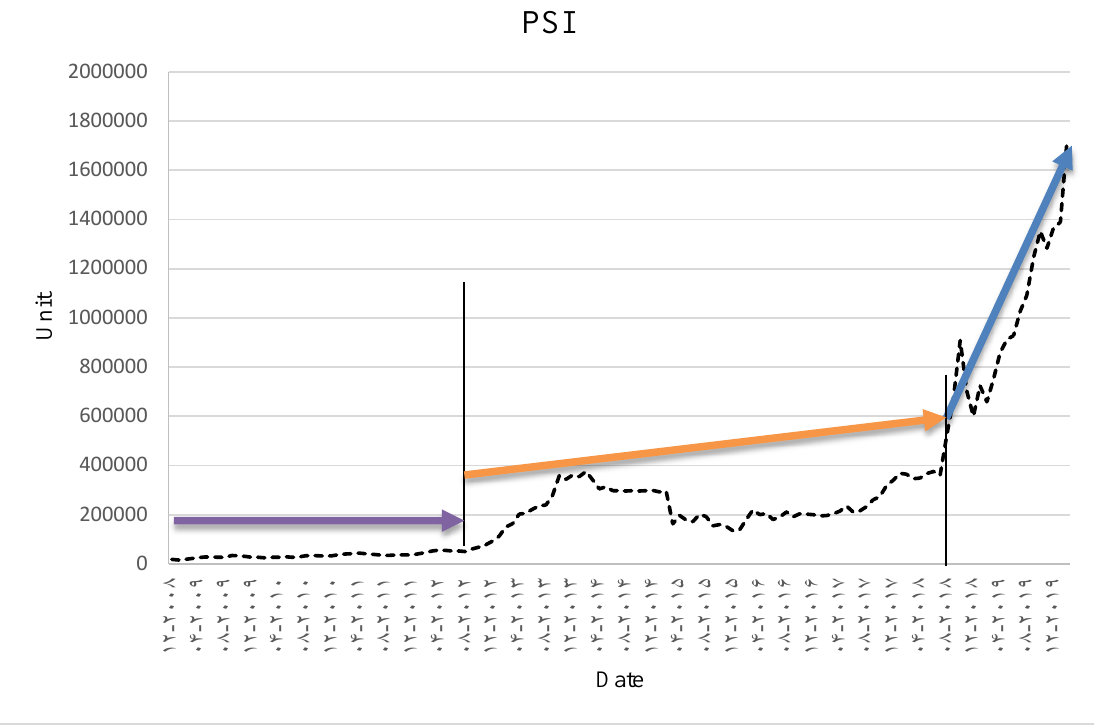
Figure 1. Time series data of the petroleum stock